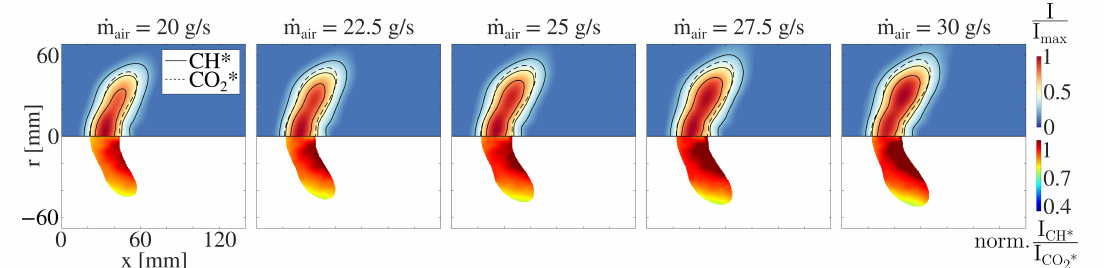
Figure 7. ( Upper half: ) Locally resolved CH* chemiluminescence intensity for natural gas combus- tion for an equivalence ratio of Φ =0.775. The solid black lines represent the 75%, 50% and 25% isolines of the chemiluminescence intensity. The dashed black line represents the 50% isoline of the corresponding CO 2 * chemiluminescence intensity. ( Lower half: ) Locally resolved CH*/CO 2 * distribution. The values are normalized to the mean CH*/CO 2 * ratio with an air mass flow rate of ˙m air =30g/s.